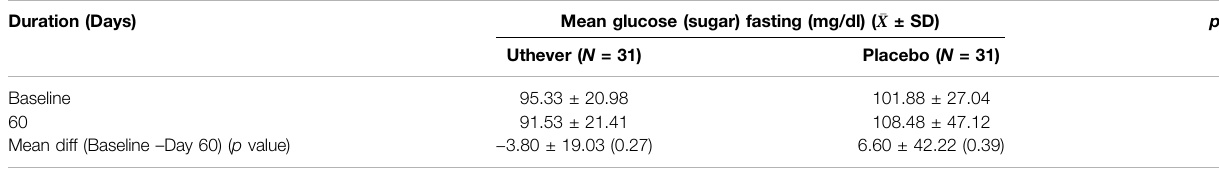
TABLE 7 | Comparison of changes in mean blood glucose (fasting) between groups.